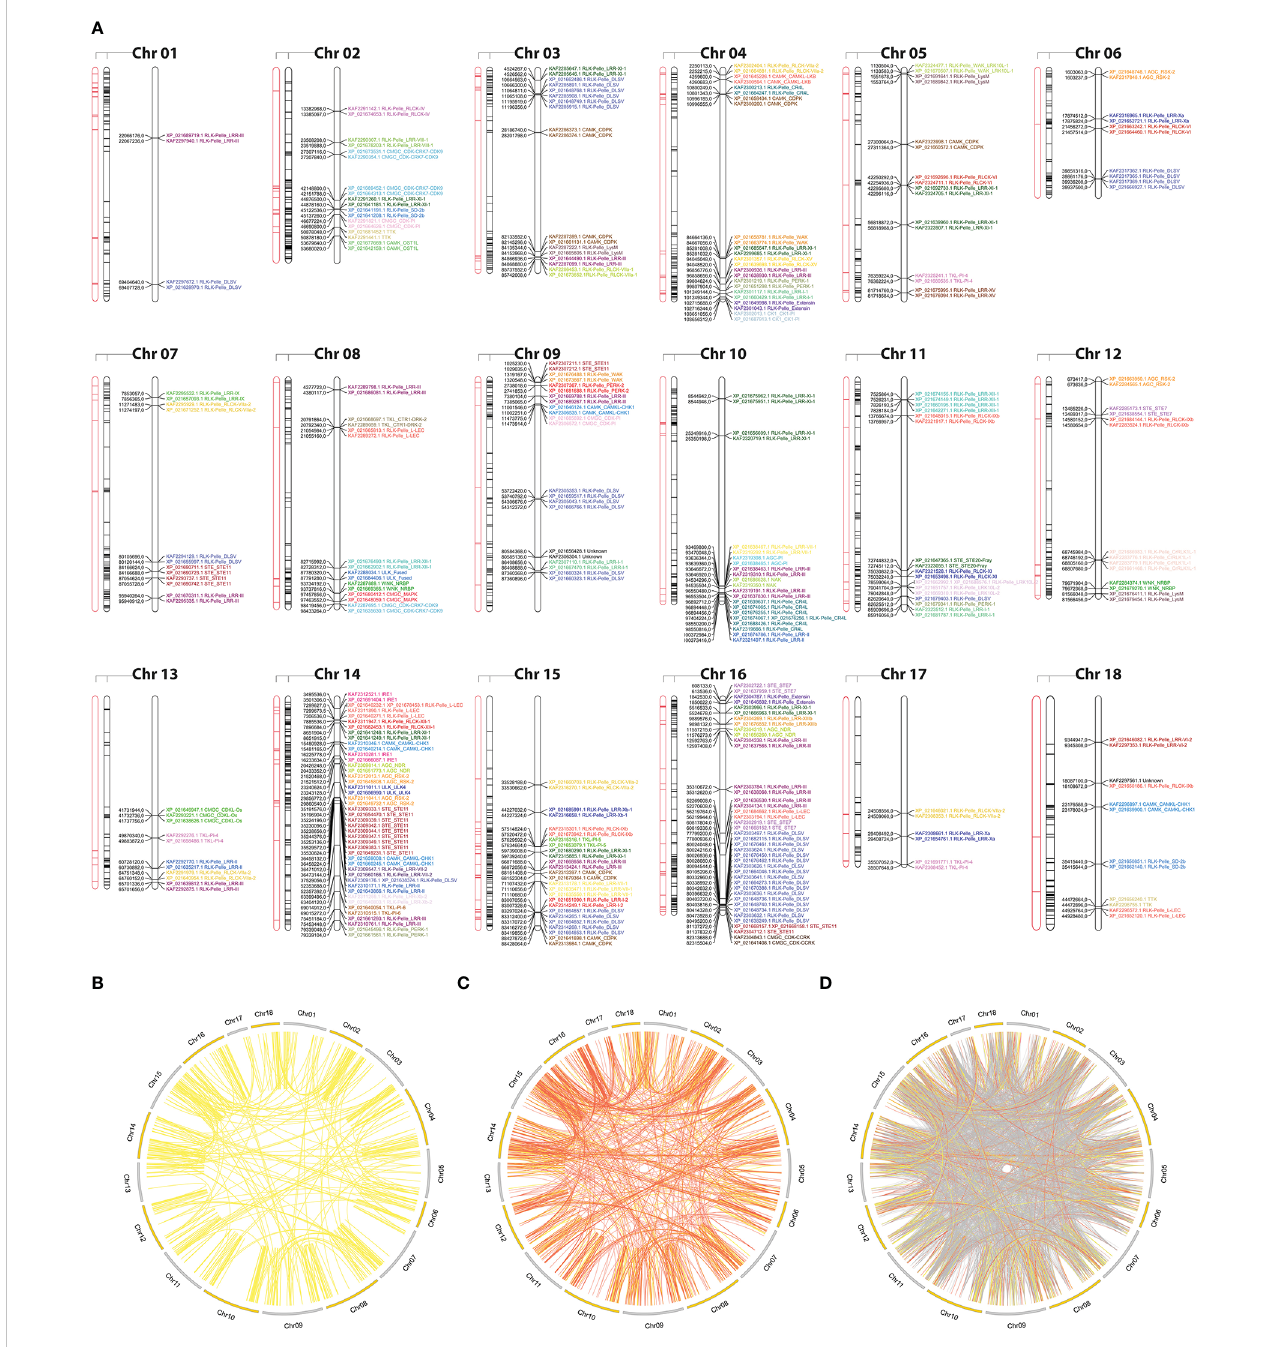
FIGURE 2 (A) Kinase distribution along Hevea brasiliensis chromosomes. For each chromosome, from left to right: (i) transposable elements located within a 100 kb window around kinase genes are highlighted in red; (ii) all genes with kinase domains are highlighted in black; and (iii) tandemly duplicated kinase genes are colored and labeled according to the kinase subfamily classi fi cation. (B) Potential segmental duplication events in the H brasiliensis genome considering similarities greater than 90% (yellow); (C) 75% (orange); and (D) 50%